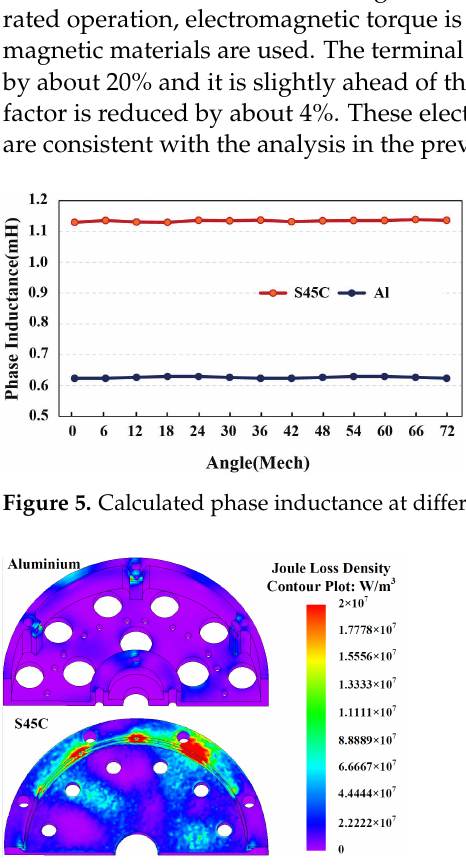
Figure 6. The Joule loss density of end caps made of different material.